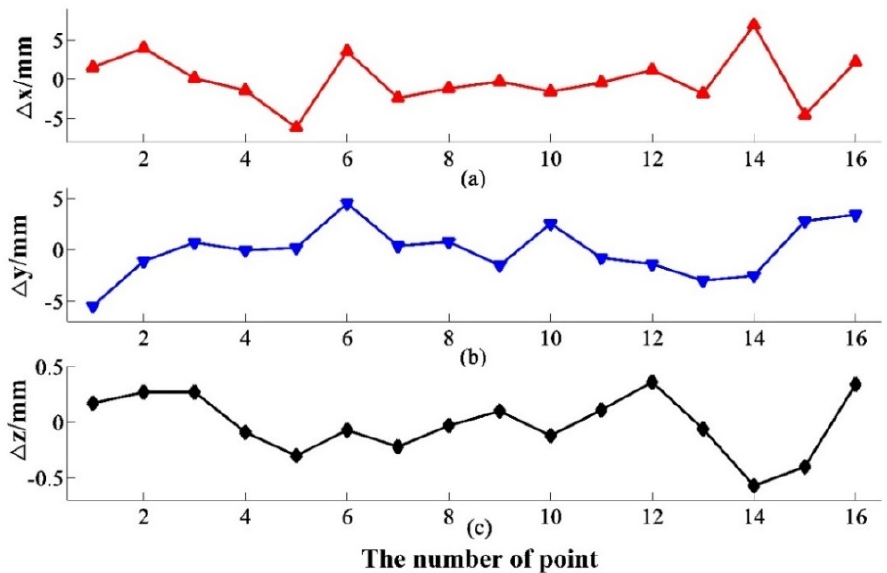
Figure 8. Layout of the 360° guidance experiment.